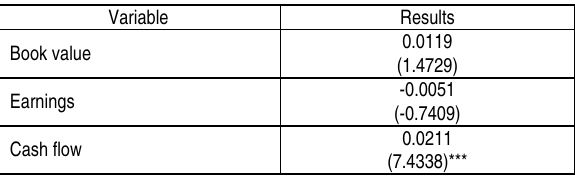
Table 7. Analyses of the inclined or decline patterns